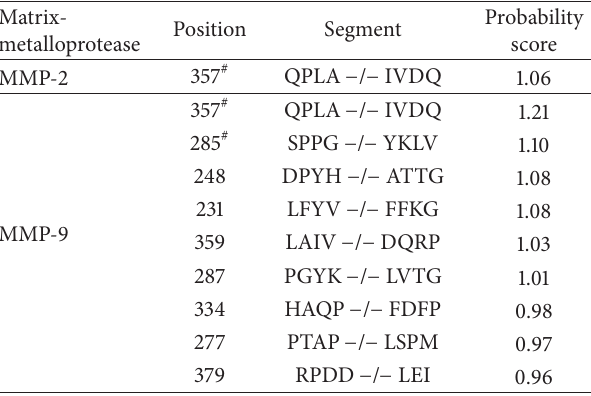
Table 2: Results of cleavage site prediction based on PROSPER ∗ in silico analysis.